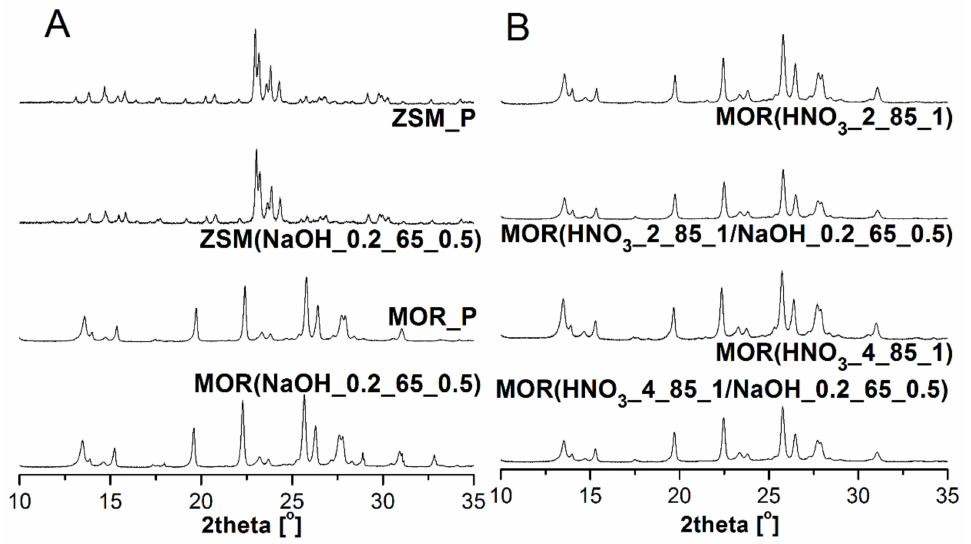
Figure 1. XRD patterns of parent and modified zeolite materials: A: ZSM-5 and B: